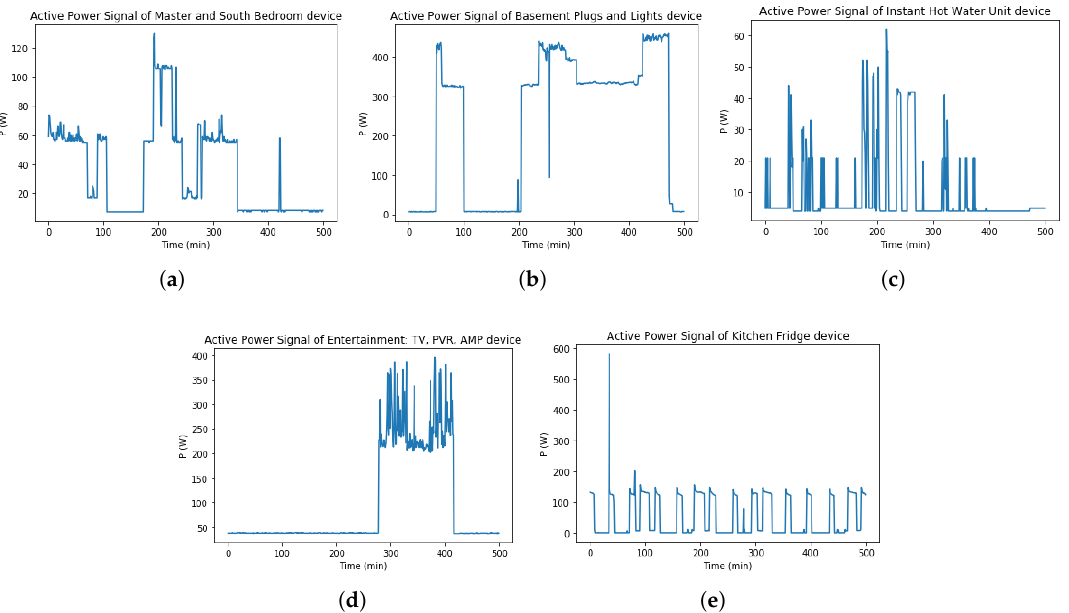
Figure 17. Active power signal of appliance data: ( a ) Master and South Bedroom; ( b ) Basement Plugs and Lights appliance; ( c ) Instant Hot Water Unit appliance; ( d ) Entertainment: TV, PVR, AMP appliance; ( e ) Kitchen Fridge